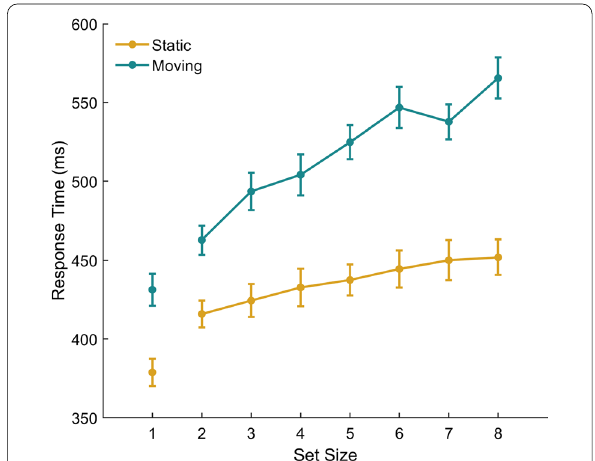
Fig. 2 Mean RT for each set size and display type. Error bars show standard